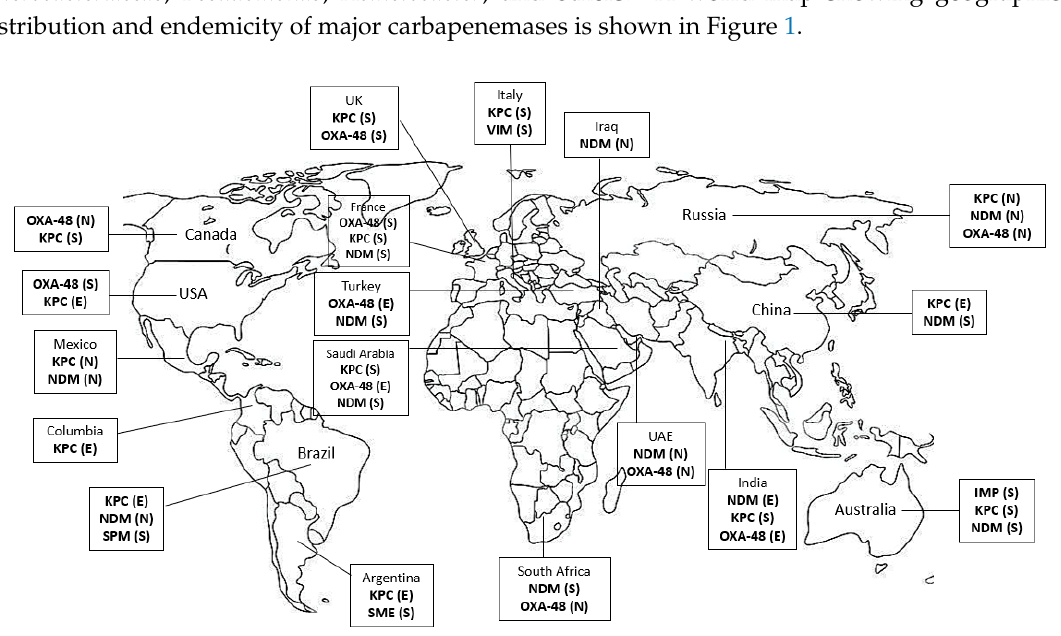
Figure 1. Worldwide distribution of KPC, NDM, VIM, IMP, SME, SPM, and OXA-48 carbapenemases with a status of dissemination. E = endemic. S = sporadic. N = newly detected. KPC =